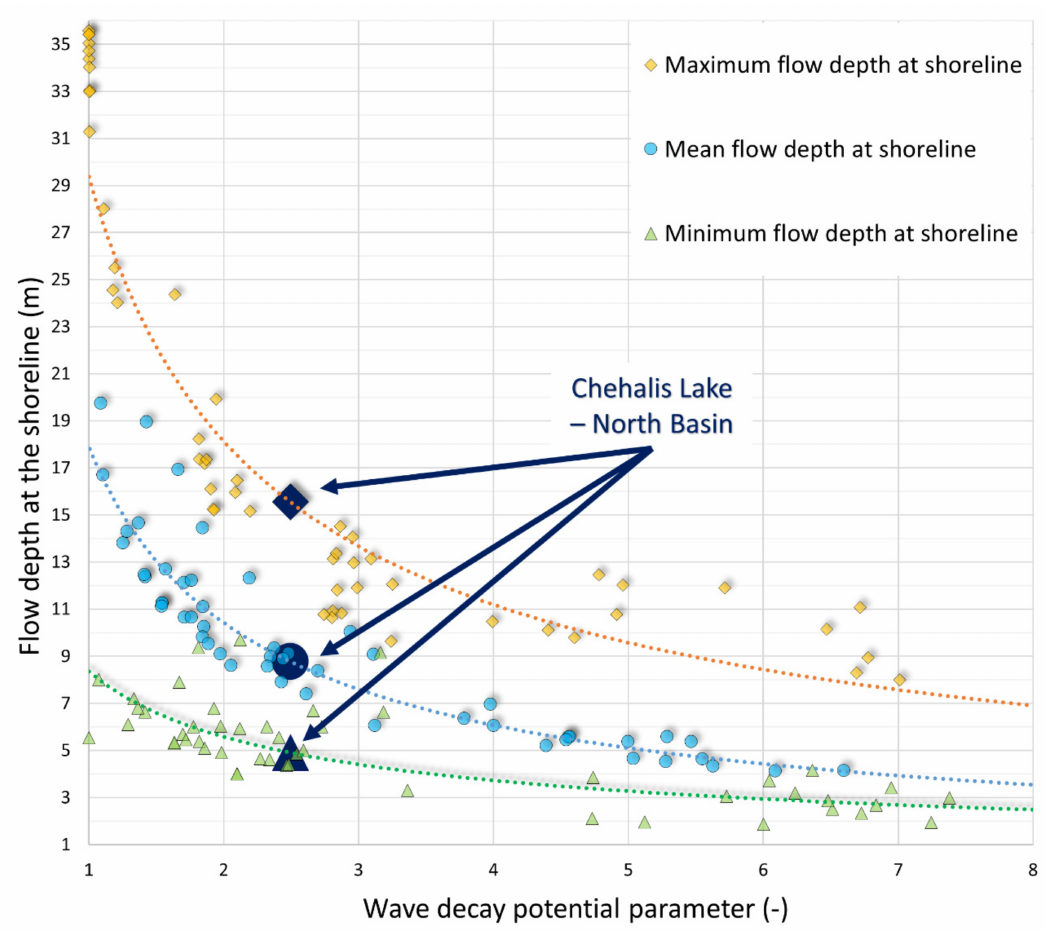
Figure 9. Hyperbolic relation between WDPP and flow depth at the shoreline (mean—blue data; maximum—orange data; minimum—green data). Flow depth values for the Chehalis Lake event (blue) are obtained using the 2019 ETH Zurich